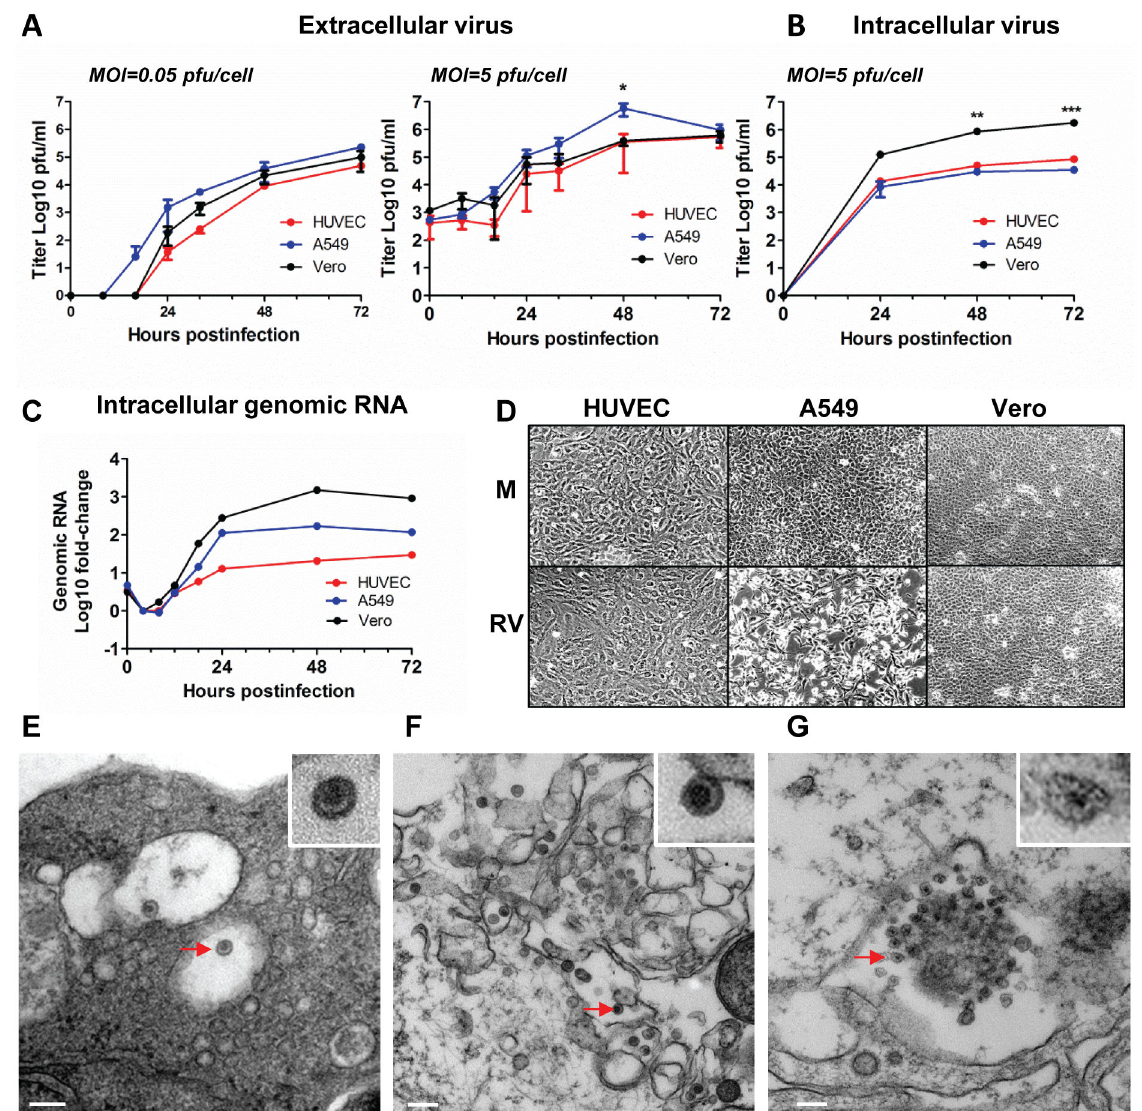
Figure 1. Productive infection of HUVEC with low passage wtRV. ( A – B ) Kinetics of RV replication in HUVEC, Vero and A549 cells. Cells were infected with RV-Dz at an MOI of 0.05 or 5. Cell culture supernatants (A) or cell lysates (B) were titered in duplicate on Vero cells. Data are presented as a mean value +/- standard deviation of two independent experiments each performed in duplicate. The data were analyzed by two-way ANOVA with the Bonferroni posttests for correcting for multiple comparisons (*, P<0.05; **, P<0.01; ***, P<0.001). ( C ) Quantitation of intracellular rubella genomic RNA. HUVEC, Vero and A549 cultures were infected with RV-Dz at an MOI of 5. Genomic RNA was quantitated by RT-qPCR. GAPDH mRNA was used for normalization in the comparative threshold cycle method. Data are presented relative to the genomic RNA amount at 4 hpi. The results represent the mean of at least two independent experiments each done in duplicate. ( D ) Phase contrast pictures of cells at 5 dpi either mock infected or RV-Dz infected at MOI=5. Note cytopathic effect of wtRV in A549. ( E ) Representative images of rubella virions observed by TEM in HUVEC infected with RV-Dz at MOI=50 at 24 hpi. ( F ) Representative images of rubella virions and ( G ) replicative complexes observed by TEMin Vero cells infected with RV-Dz at MOI=50 at 24 hpi. Inserts represent enlarged images from the replicative complex and virions that are marked with the red arrows. Bars, 100 nm.